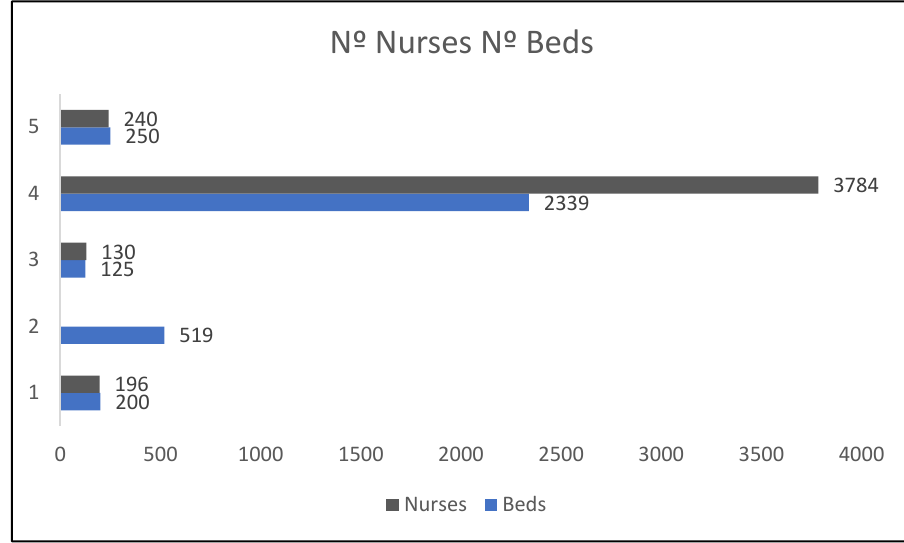
Figure 2. Comparison of number of nurses and number of beds.